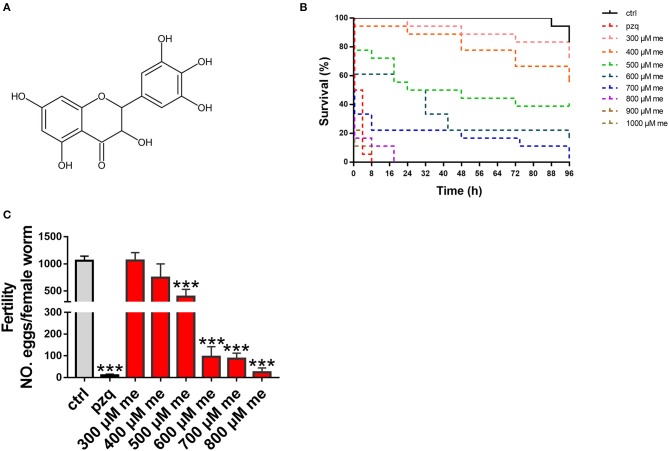
In vitro effects of myricetin on the activity of S. japonicum. (A) Chemical structure of myricetin (C15H10O8, MW318.24) (B) Insecticidal activity myricetin against S. japonicum in different time intervals and concentrations in the laboratory (C) Pairs of adult worms were treated with myricetin in different concentrations (300, 400, 500, 600, 700, and 800 μM) for 96 h, and the number of eggs laid in culture was counted under an inverted microscope. As positive pzq and negative control ctrl group, adult worms were incubated in RPMI 1,640 medium with praziquantel (100 μM) or 1% DMSO, respectively. Data were shown as the means ± SD (n = 3). ***P < 0.001, compared with the negative ctrl group.